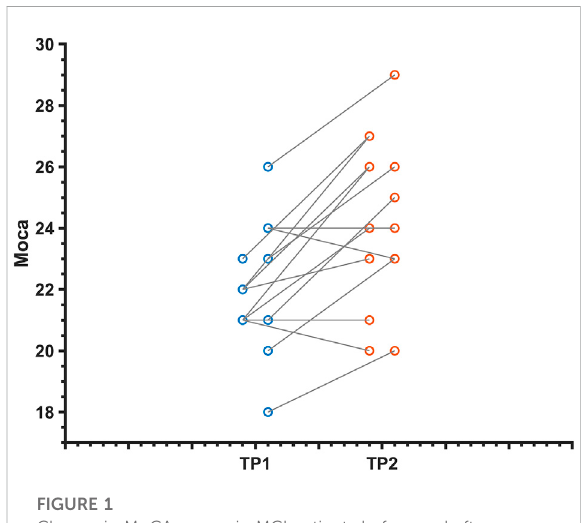
FIGURE 1 Change in MoCA scores in MCI patients before and after dual-target rTMS